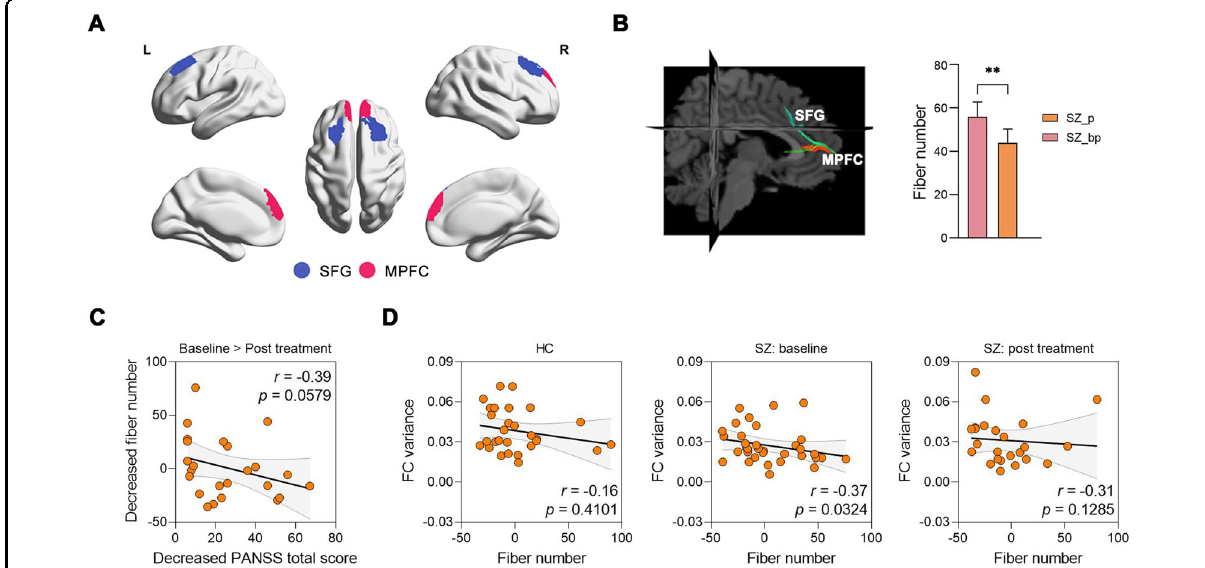
Fig. 4 Structural connectivity association analyses. A Spatial maps of two components (SFG and MPFC). B Differences in number of diffusion streamlines in patients between baseline (SZ_p) and follow-up (SZ_bp). C Decreased number of streamlines between the SFG and MPFC were marginally negatively correlated with decreased PANSS scores in patients after treatment. D Relationship between FC variability and number of streamlines in each groups. ** P < 0.01. SFG = superior frontal gyrus; MPFC = medial prefrontal